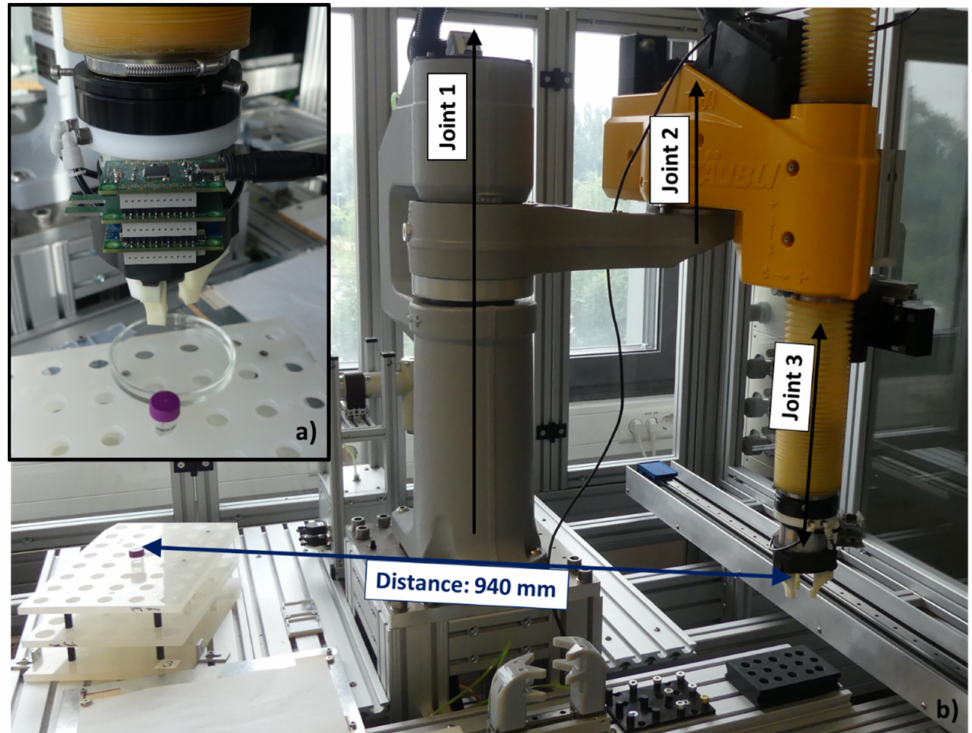
Figure 14. Experimental setting using the SCARA TS60. ( a ) Sensor node attached to the gripper which is above the tube. The petri dish is positioned opposite to the sensor node. ( b ) Joint 1 and 2 are rotatory joints and act around the z -axis. Joint 3 is a translatory joint and is acting in z-direction (up and down). Further the distance between the start position (also the end position) and the position of the tube to be picked up is